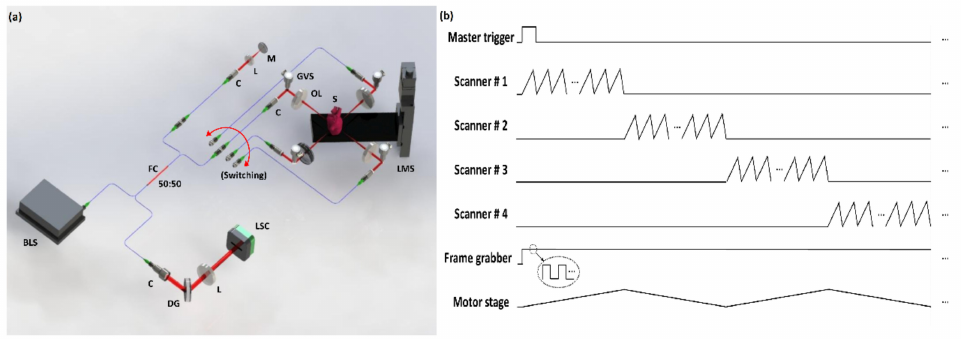
Figure 2. The optical configuration and duty cycle diagram of sequential quad-scanner (QS)-OCT system. ( a ) Sequential QS-OCT for successive operation of each scanner. ( b ) The duty cycle illustration of sequential QS-OCT system operation. BLS, broadband light source; C, collimator; DG, diffraction grating; FC, fiber coupler; GVS, galvanometer scanner; L, lens; LMS, linear motor stage; LSC, line-scan camera; OL, objective lens; S,